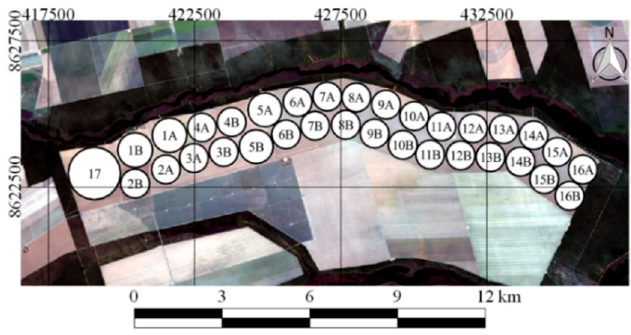
Figure 2 . Arrangement of pivots in the study area.